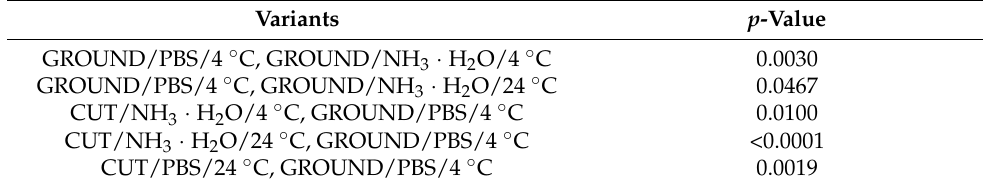
Figure 5. Evaluation of residual detergent content in the final product (i.e., in dECM powder) depending on how the tissue was minced (cut vs. ground), the solution used for rinsing (NH 3 · H 2 O vs. PBS), and temperature (4 °C vs. 24 °C). Table 2. p -values obtained for the results presented in Figure 5.